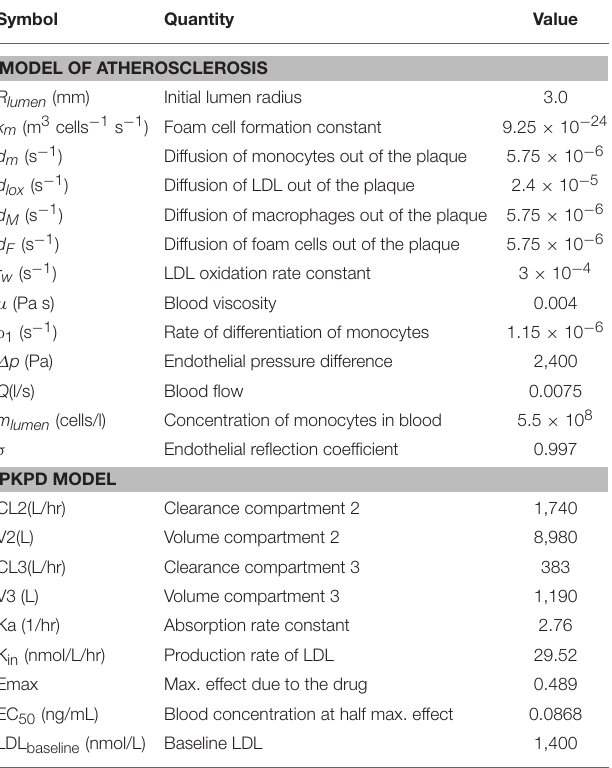
TABLE 1 | Quantitative systems pharmacology model: parameter values for a Typical Patient .